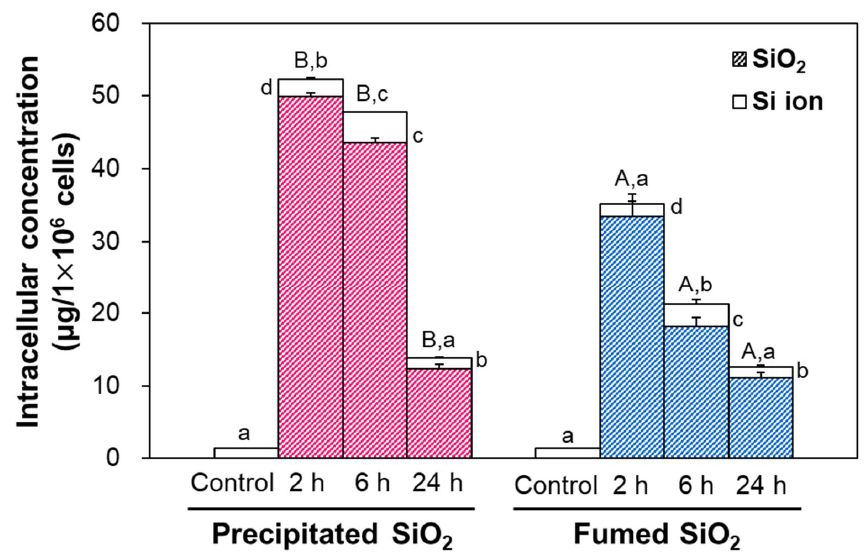
Figure 5. Intracellular uptakes and fates of SiO 2 in Caco-2 cells, obtained via cloud point extraction (CPE). Different uppercase letters (A,B) indicate significant differences in total intracellular Si levels between precipitated SiO 2 and fumed SiO 2 ( p < 0.05). Different lowercase letters (a,b,c,d) indicate significant differences between different incubation times ( p < 0.05).